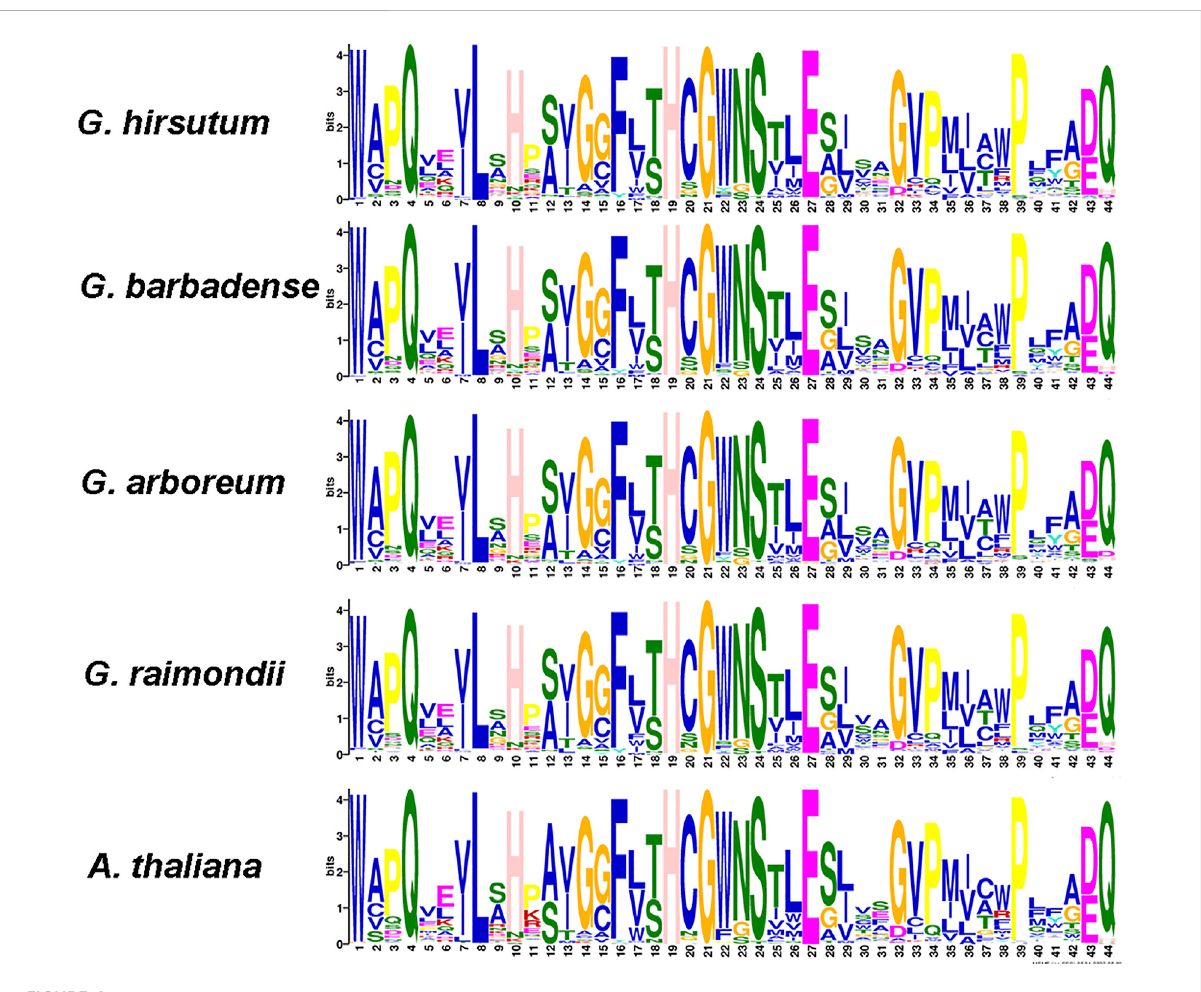
FIGURE 4 Consensus sequence logos of the PSPG-box in fi ve plant